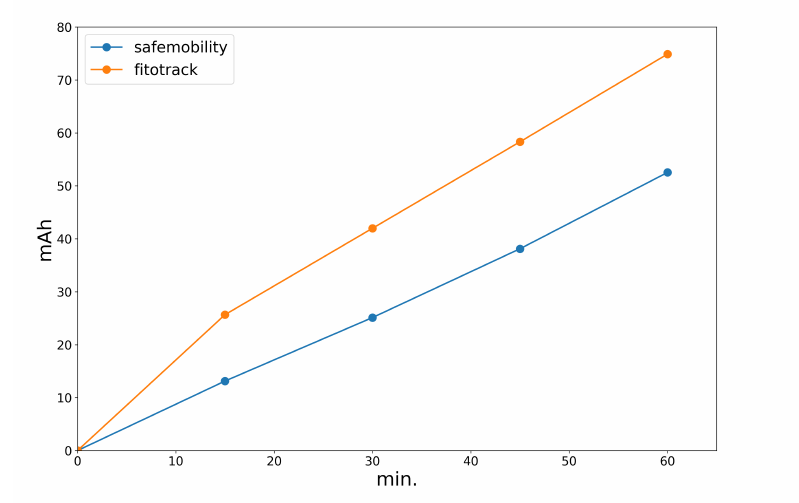
Figure 12. Battery consumption comparison for the Fitotrack and SafeCyclists applications over time. In both cases, the phone screen was turned off.